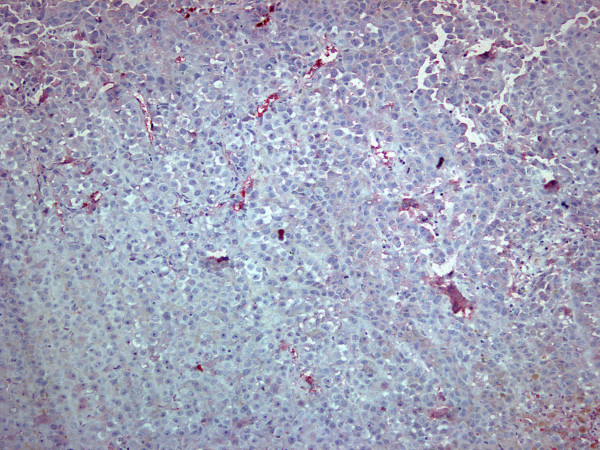
Immunohistochemical staining for bFGF in group I (control): Microvessels are represented by red clusters, which stand out sharply from other tissues.